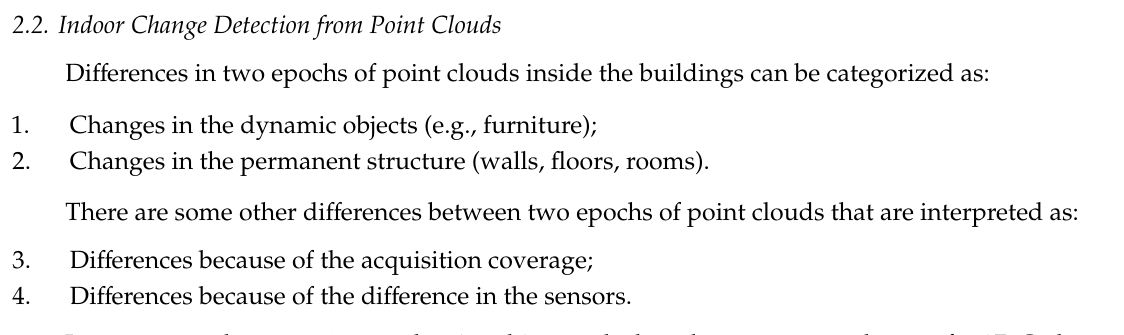
Figure 5. The datasets for two different epochs. The first row is the dataset which belongs to the Braunschweig building and the second row is from the ITC building and is a more complex dataset, with furniture and large glass windows.